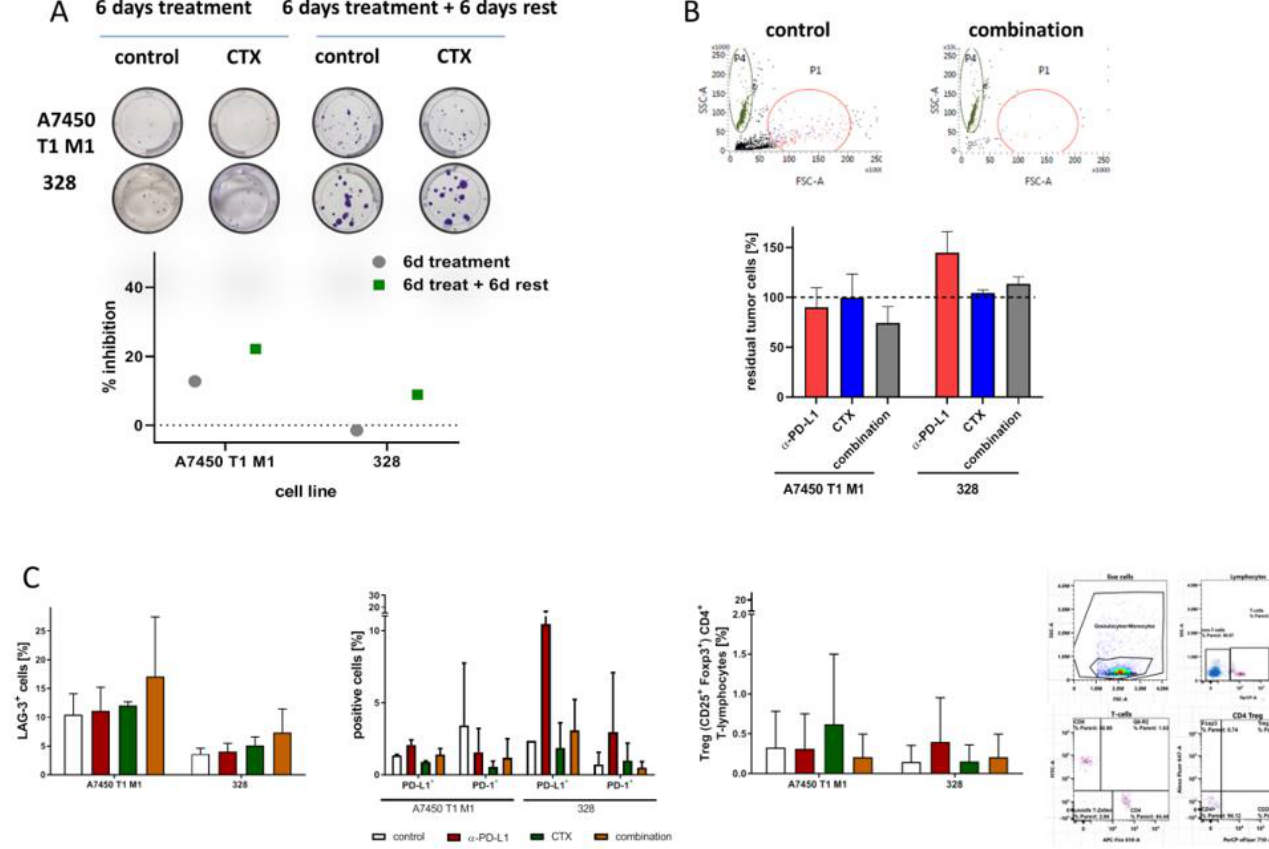
Figure 1. In vitro colony formation assay and co-culture. ( A ) Colony formation assay. Mlh1 −/− cell lines A7450 T1 M1 and 328 were treated for 6 days with gemcitabine. Colonies were counted either directly after treatment or after an additional 6 days of rest. ( B ) Co-culture of tumor cells with murine immune cells. After 72 h, cells were counted and ( C ) immune cells were phenotyped. The gating strategy is shown on the right side, next to the bar charts. Events shown within the dot plots represent mean of the numbers of positive cells ± SD resulting from 20,000 events.